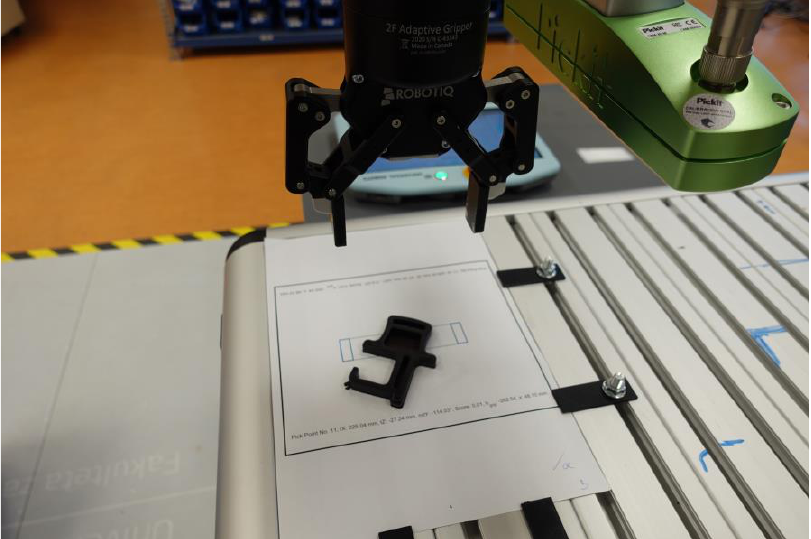
Figure 13. The test setup consists of UR5e collaborative robot, a Robotiq FT-85 2-F gripper, a 3D- printed template holder, and a paper-printed position template. Source: own.